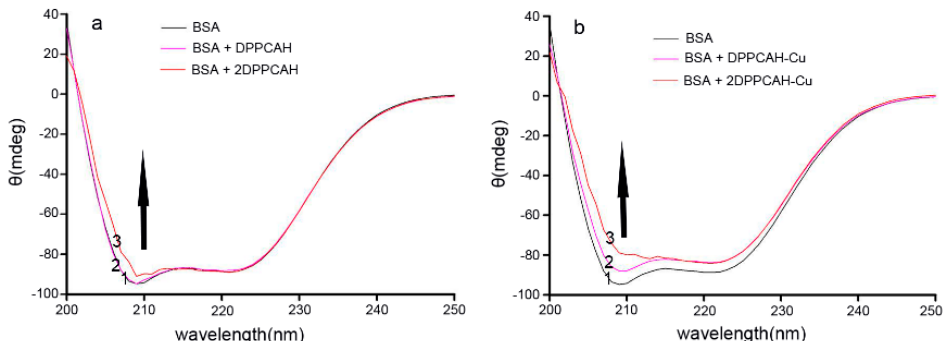
Figure 8. The CD spectra of ( a ) DPPCAH-BSA and ( b ) DPPCAH-Cu-BSA system: DPPCAH (or DPPCAH-Cu) concentrations were 0.0, 15, and 30 μ M from 1 to 3, respectively. C BSA = 15 μ M, pH = 7.4, and T = 288 K.